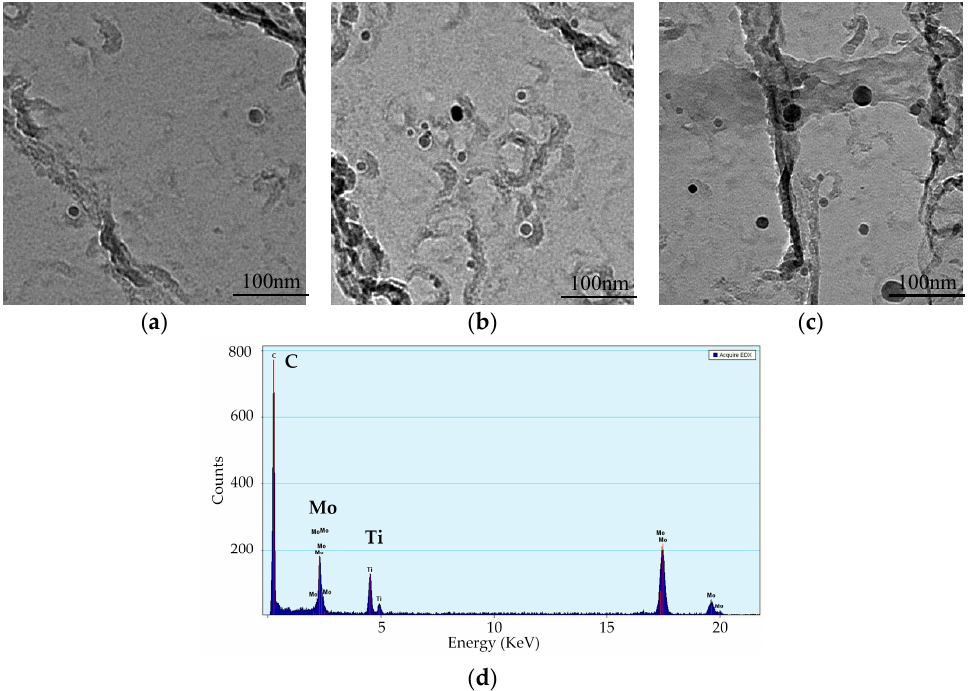
Figure 7. Precipitation distribution of S4 steel at different cooling rates: ( a ) 0.13 °C/s; ( b ) 0.0094 °C/s; ( c ) 0.0038 °C/s; ( d ) energy dispersive spectrometer (EDS) of TiC through carbon extraction replicas with Mo mesh.